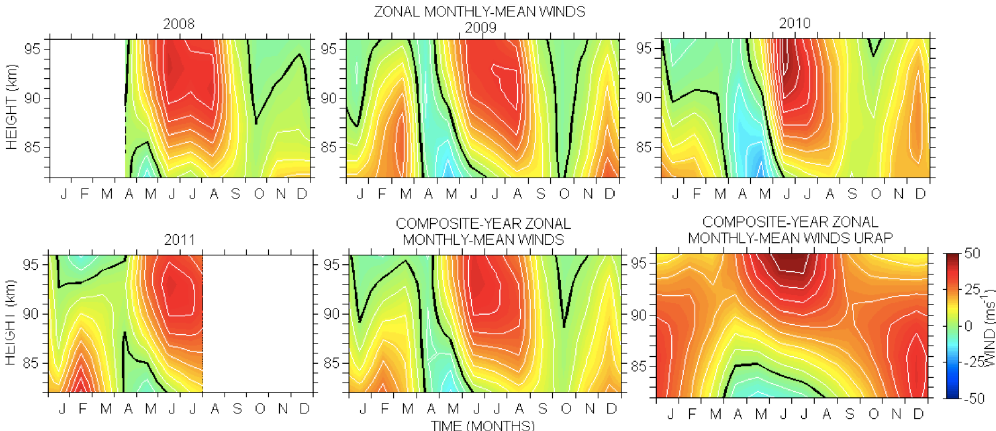
Fig. 2. Monthly-mean zonal winds and the zonally averaged composite-year monthly-mean zonal URAP winds over BLO. The zero wind contour is indicated in black and the white contours are in steps of 5 ms − 1 .